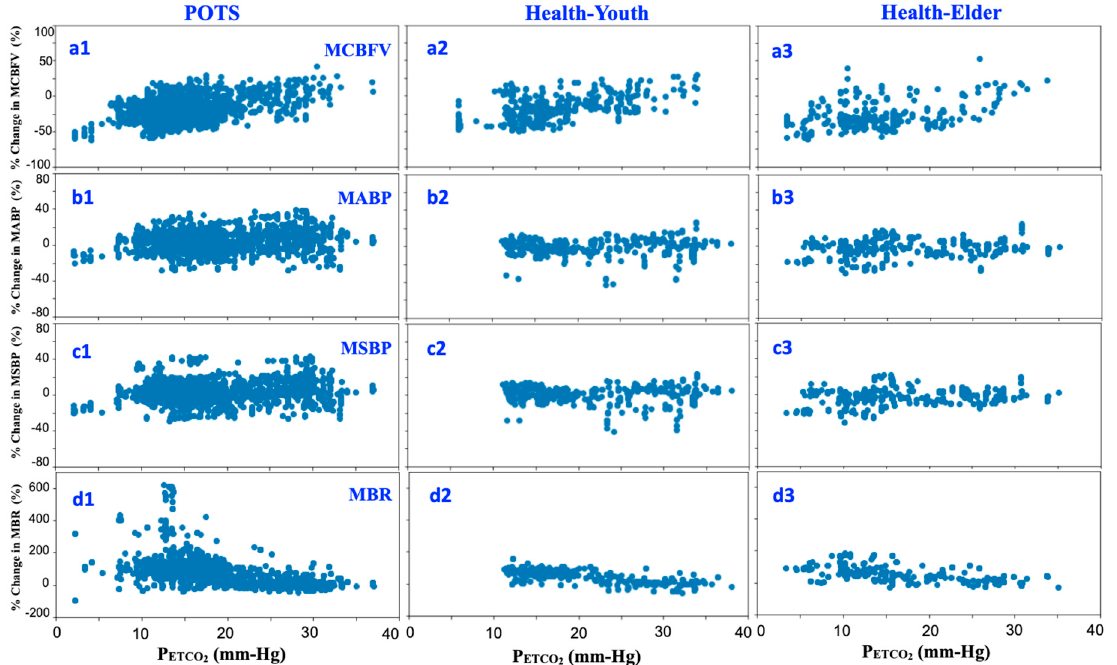
Figure 5. Linear analysis of percentage change in cardiorespiratory signals based on the variation in P ETCO 2 : ( a1 – a3 ) MCBFV; ( b1 – b3 ) MABP; ( c1 – c3 ) MSBP; and ( d1 – d3 ) MBR during the initial 30 s of